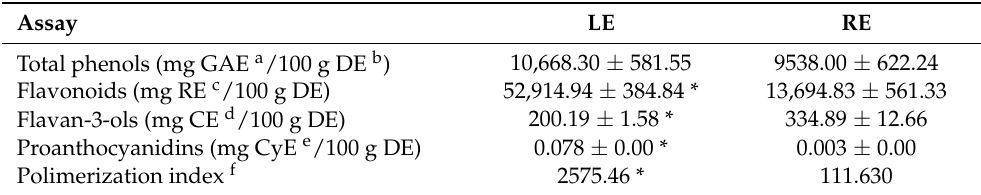
Table 1. Phytochemical screening of P. ostruthium leaf and rhizome hydroalcoholic extracts (LE and RE, respectively). Results are the mean ± standard deviation (S.D.) of three independent experiments in triplicate ( n = 3). Assay